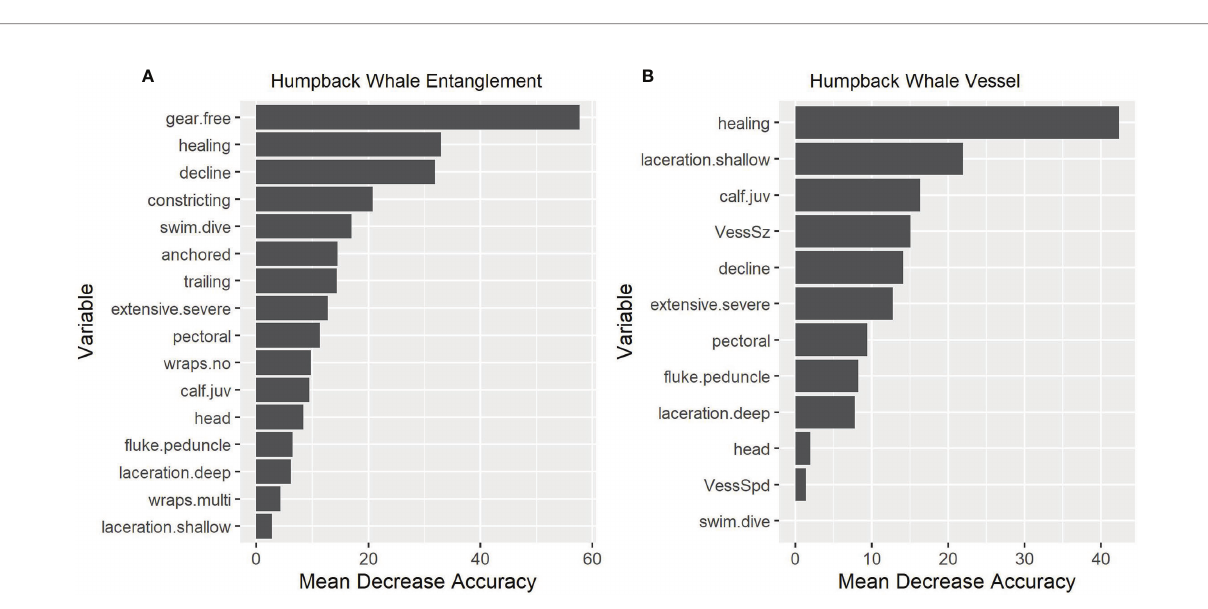
FIGURE 2 | Variable importance for entanglement (A) and vessel strike (B) models for right whales. The x-axis shows the mean decrease in classi fi cation accuracy (number of additional cases misclassi fi ed across all trees) when individual variables are permuted.